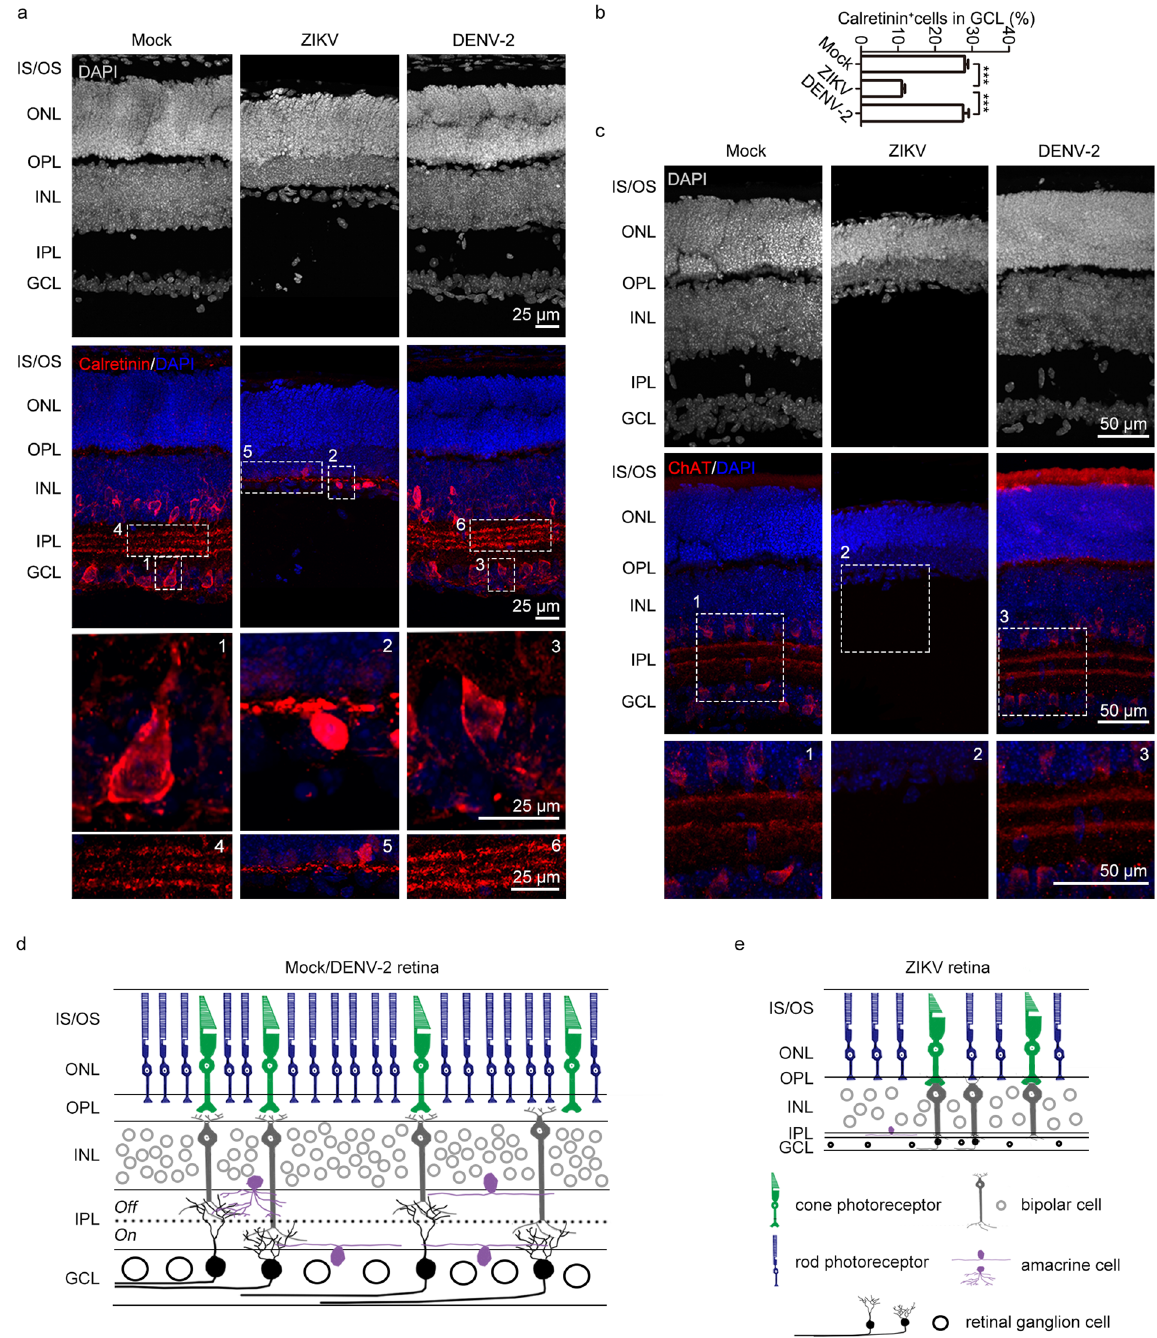
Figure 3. Few retinal ganglion cells and no starburst amacrine cells were left after maternal ZIKV infection. (a) P14 retinal Calretinin immunostaining. (b) Percentage of Calretinin-positive cells in the GCL. n Mock = 7, n ZIKV = 5, n DENV-2 = 8 samples from three independent experiments. Data are presented as the mean ± SEM. One-way ANOVA with Bonferroni’s post hoc test, *** p < 0.001. (c) P14 retinal ChAT immunostaining. (d,e) Schematic depiction of a normal retina in mock- or DENV-2 infected mice (d) or a pathological retina in ZIKV- infected mice